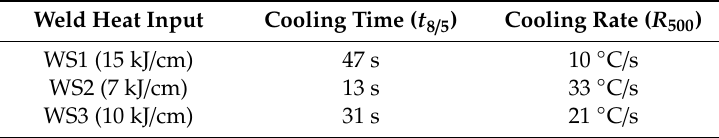
Table 3. Calculated cooling rates for the three heat inputs.